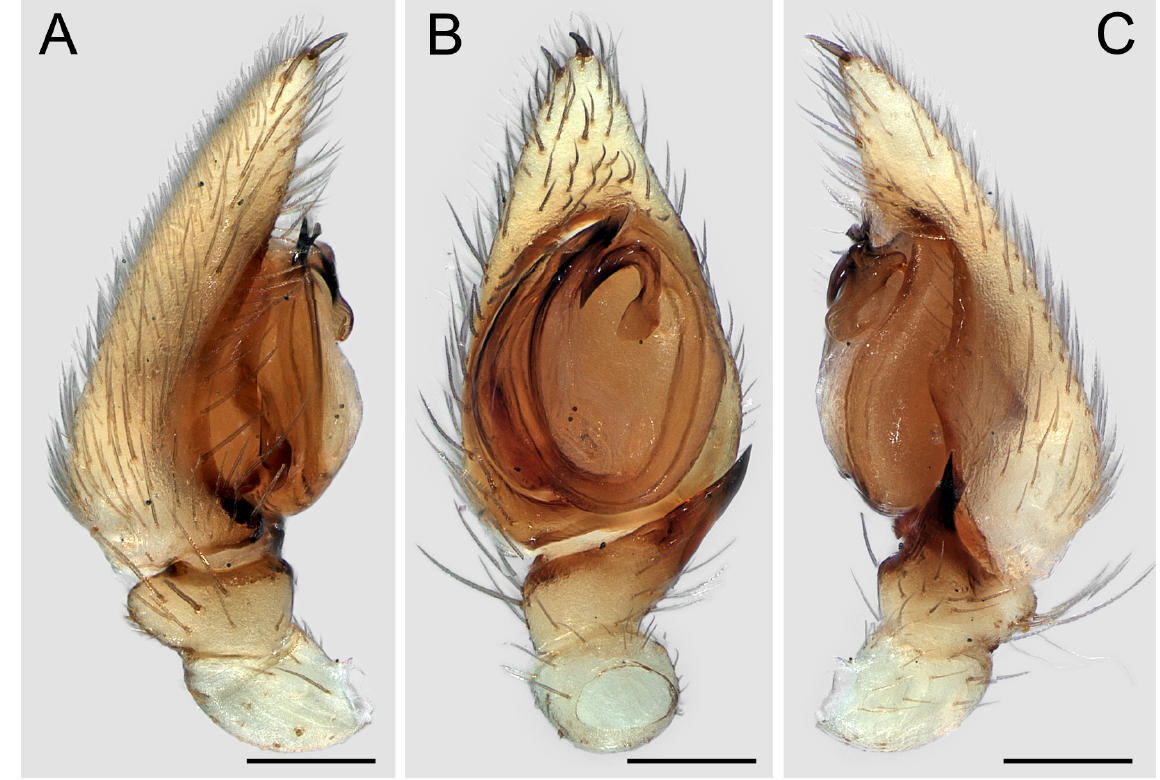
Fig. 2. Acanthinozodium crateriferum sp. nov., holotype ♂, palp. A . Prolateral view. B . Ventral view. C . Retrolateral view. Scale bars = 0.2